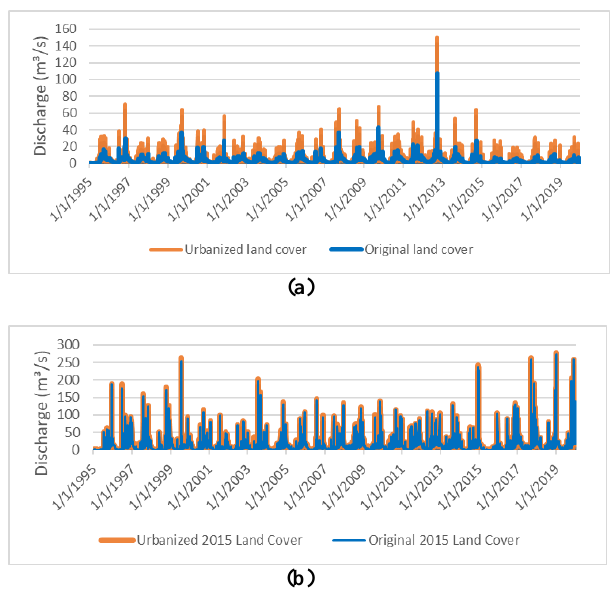
Figure 8 . Simulated annual mean peak discharges for (a) Tanay subbasin and (b) Pagsanjan subbasin.